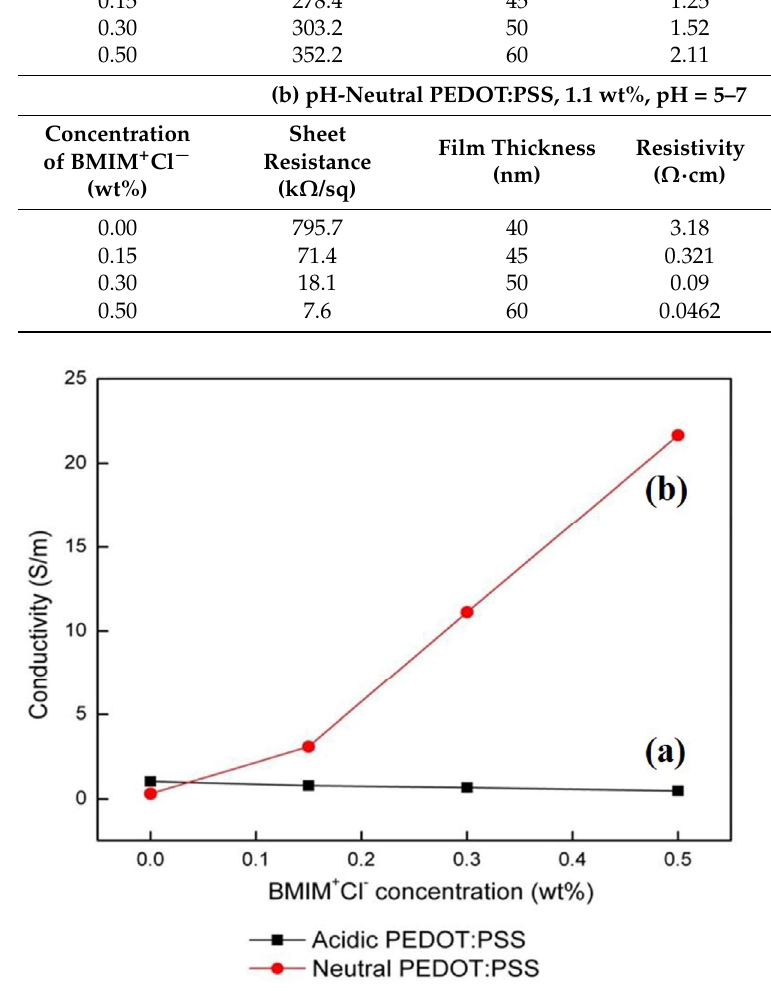
Figure 4. The conductivity of BMIM + Cl − -doped ( a ) acidic PEDOT:PSS and ( b ) pH-neutral PEDOT:PSS films.